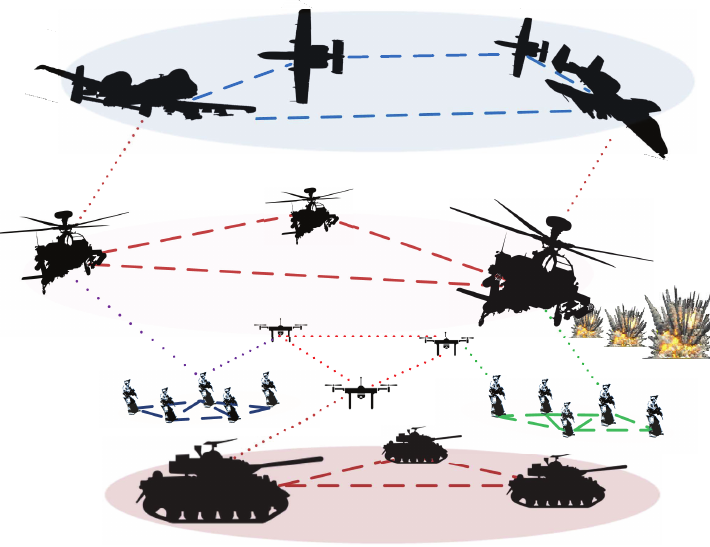
Figure 1. A sample multilayer IoBT ad hoc